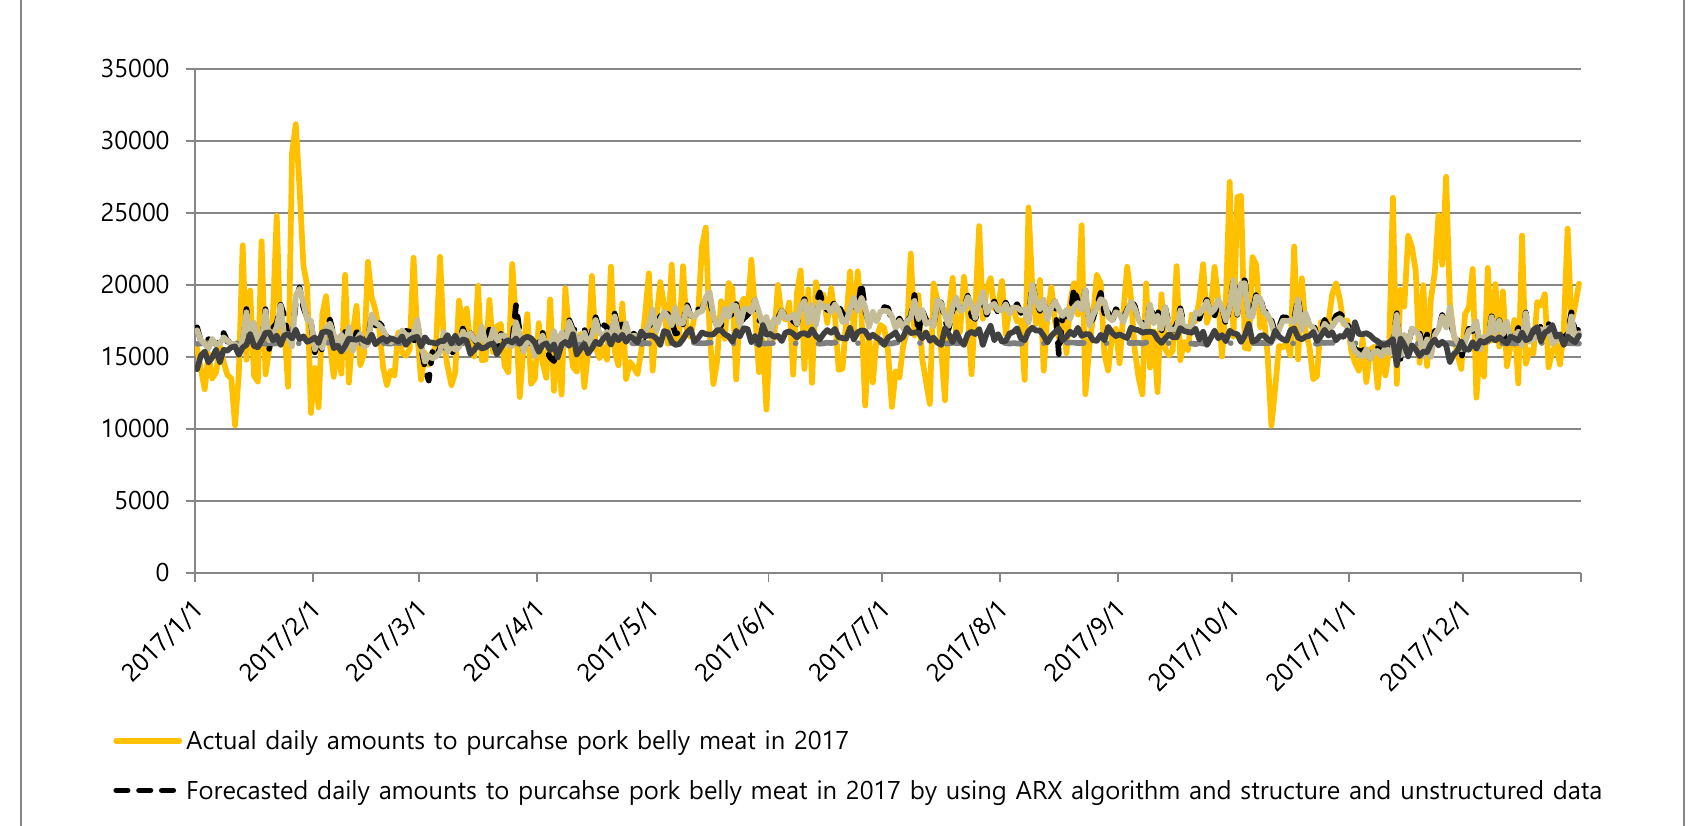
Figure 4. Comparison of forecasted daily amounts to purchase pork belly meat in 2017. ARX = Autoregressive exogenous, LSTM = Long short-term memory.